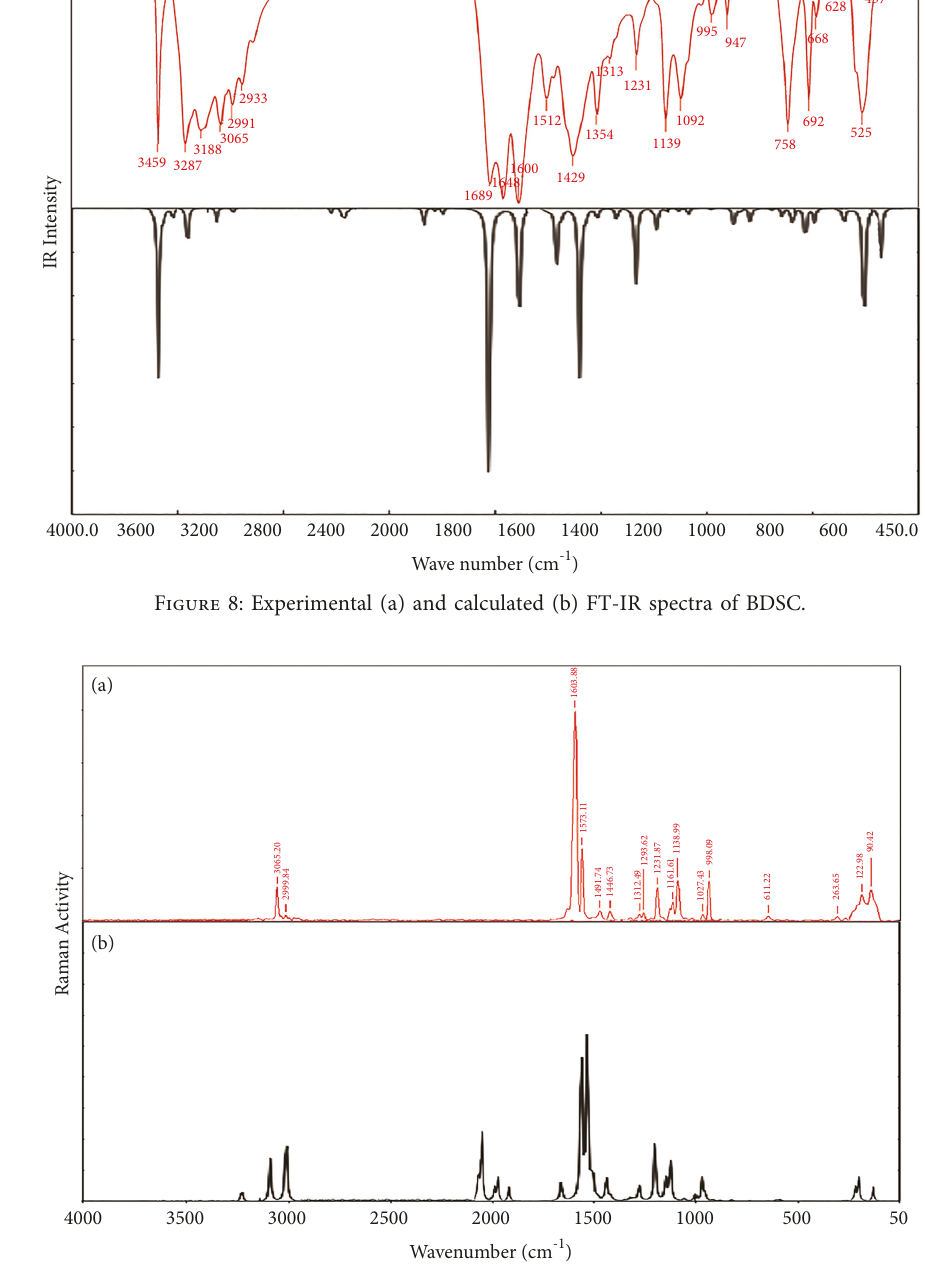
Figure 9: Experimental (a) and calculated (b) FT-Raman spectra of